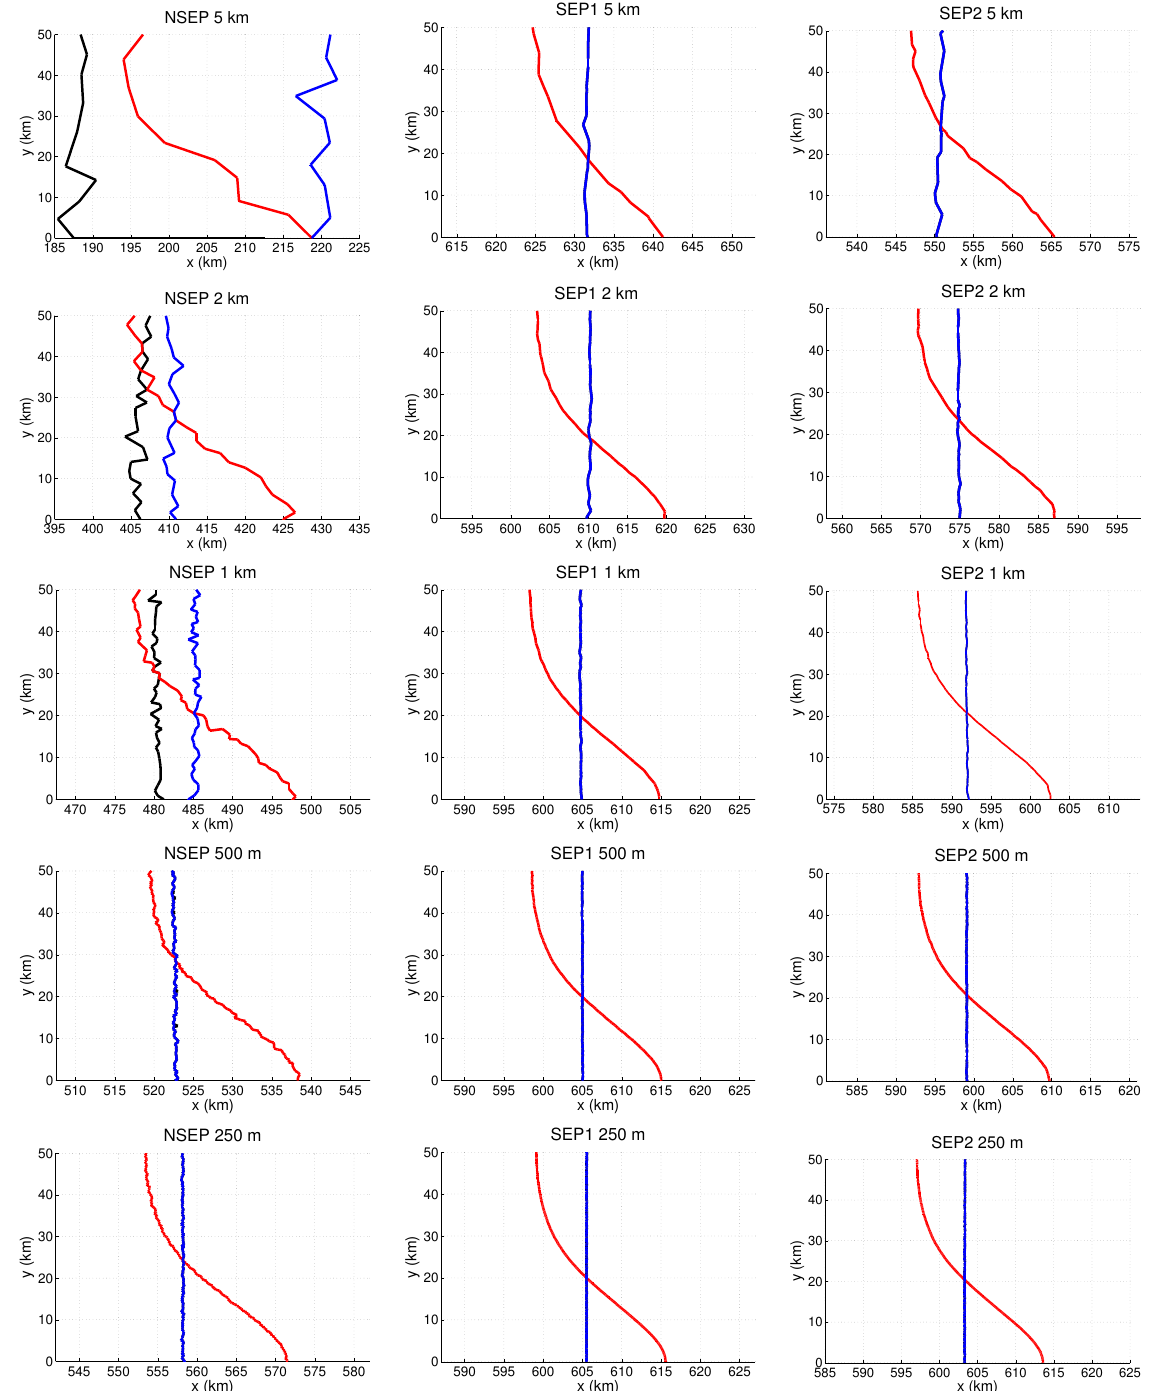
Figure 3. Initial steady state grounding line positions in the ( x , y ) plane (black line), position 100 years after the basal perturbation is introduced (red line) and new steady state position after the basal friction is reset to its initial value (blue line). Where black line is not visible, black and blue lines superimpose. x and y axis have the same scale for all plots.